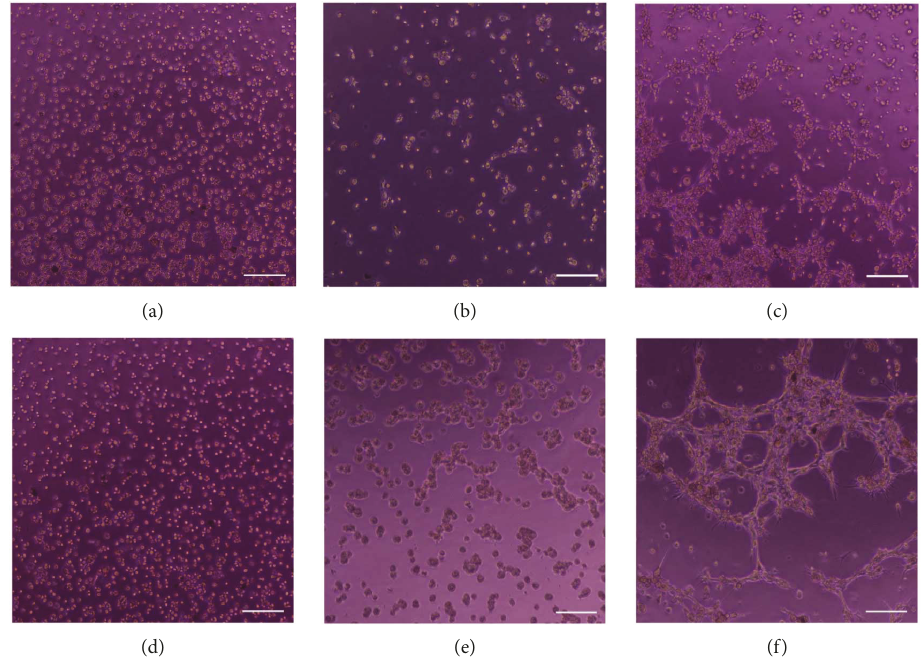
Figure 4: Endothelial-like cell tube formation assay. The chondrocytes after 6 hours (a) and 12 hours (d), the bMSCs after 6 hours (b) and 12 hours (e), and the endothelial-like cells after 6 hours (c) and 12 hours (f). There are tube formations at endothelial-like cells after 12 hours (f). The scale bar indicates 500 μ